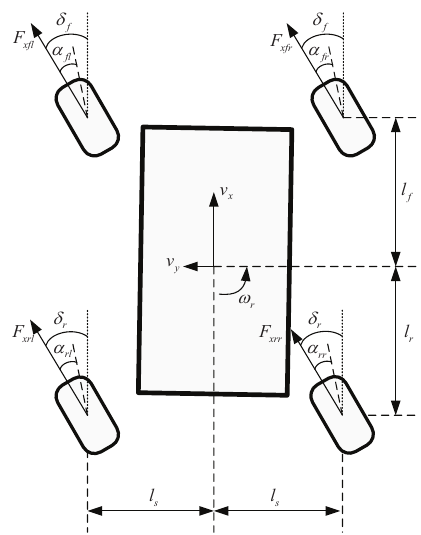
Figure 3. Vehicle structure model used for